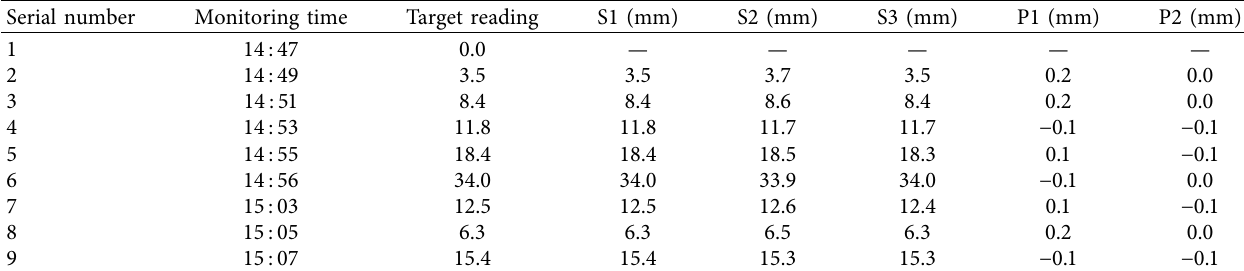
Table 3: Experimental table comparing the accuracy of the L1 target in the vertical direction.